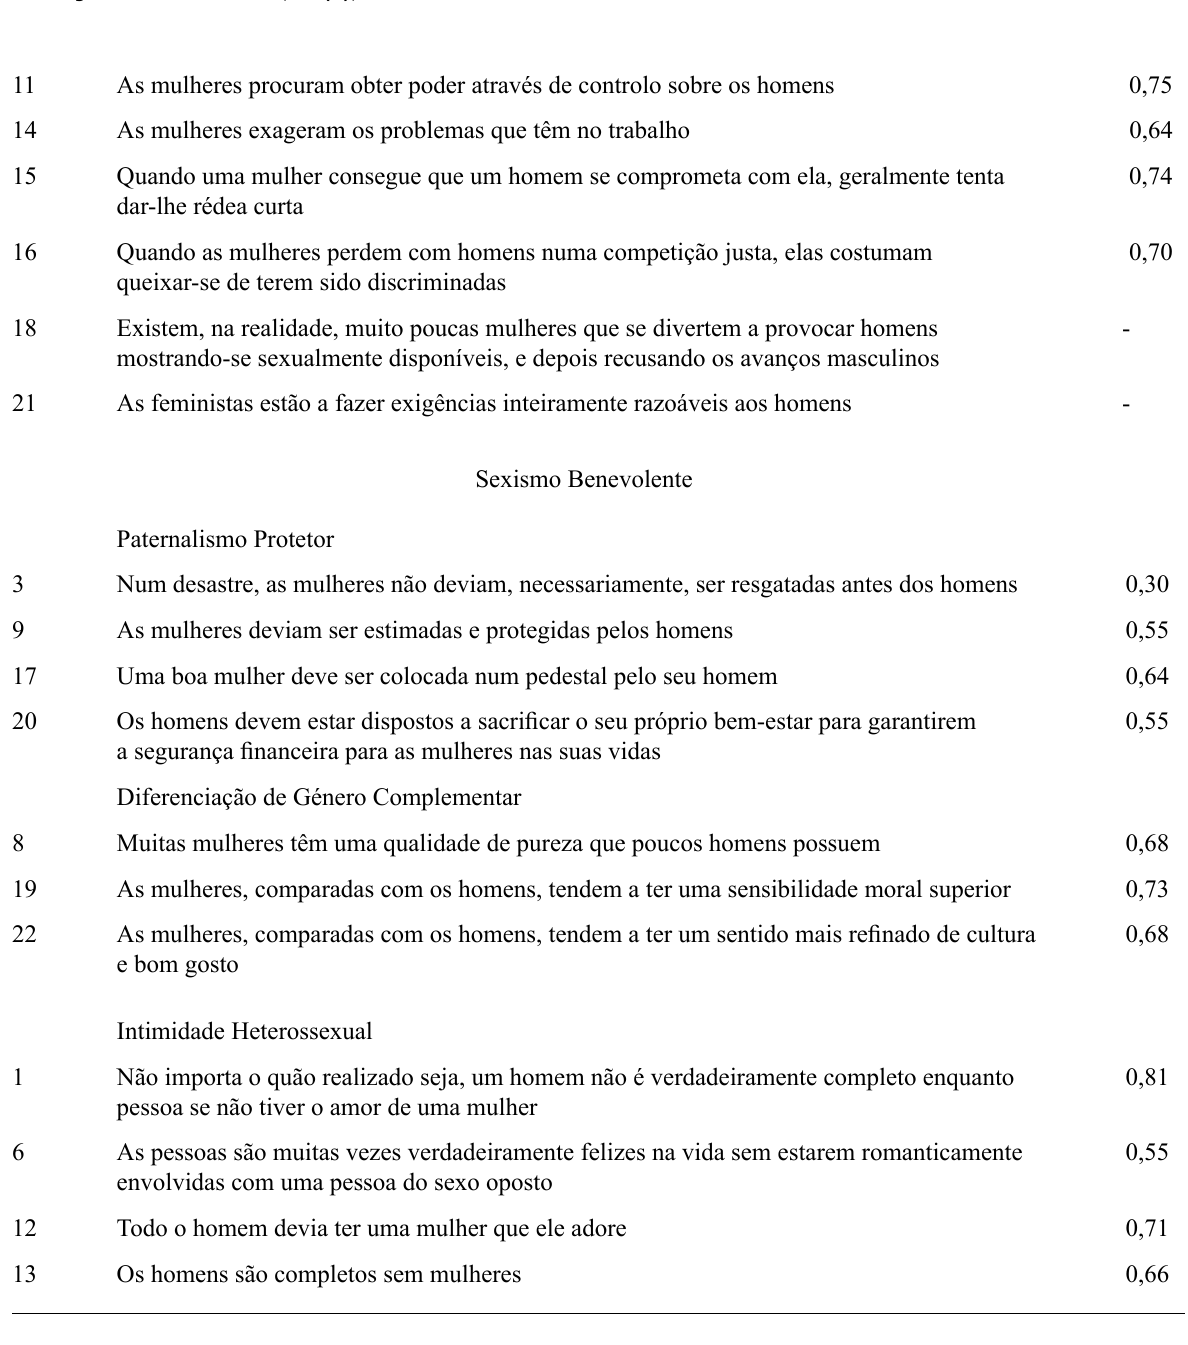
signi fi cativamente no respetivo fator de 2ª ordem. A esta- tística do Qui Quadrado foi signi fi cativa ( χ 2 = 314,974, gl = 162, p < 0,001), embora os restantes índices de ajustamento tenham revelado um bom ajustamento do modelo (CFI = 0,91; GFI = 0,89; RMSEA = 0,06). A validade fatorial individual foi observada em todos os casos (Tabela